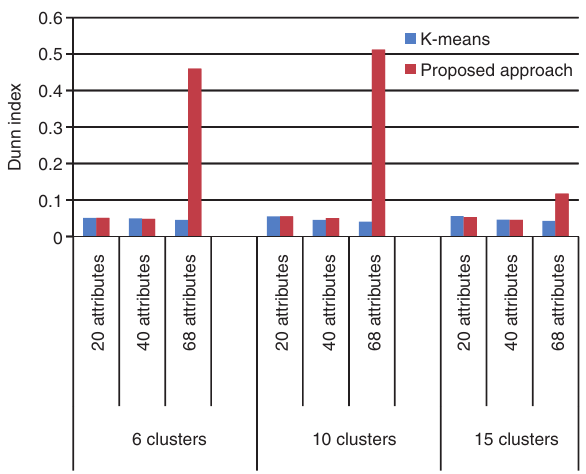
Figure 7: Comparison of Obtained Results for Uscensus Dataset Based on Dunn Index.